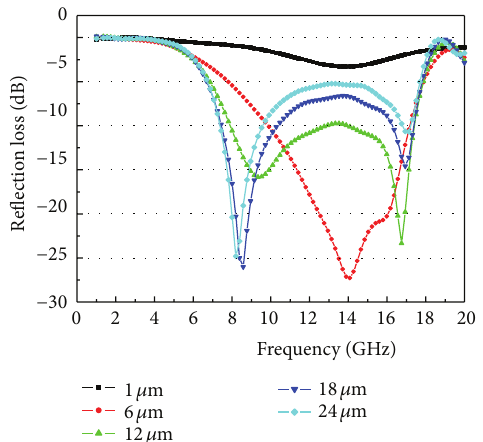
Figure4:Simulationmodel:reflectionlosschangewithdifferentCP thickness.